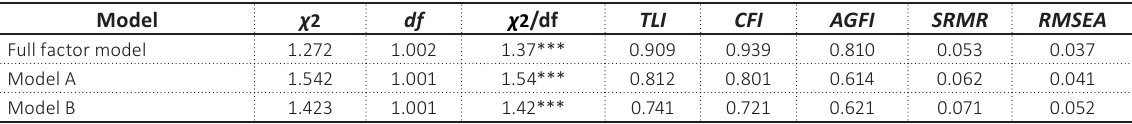
Table 1. Measurement